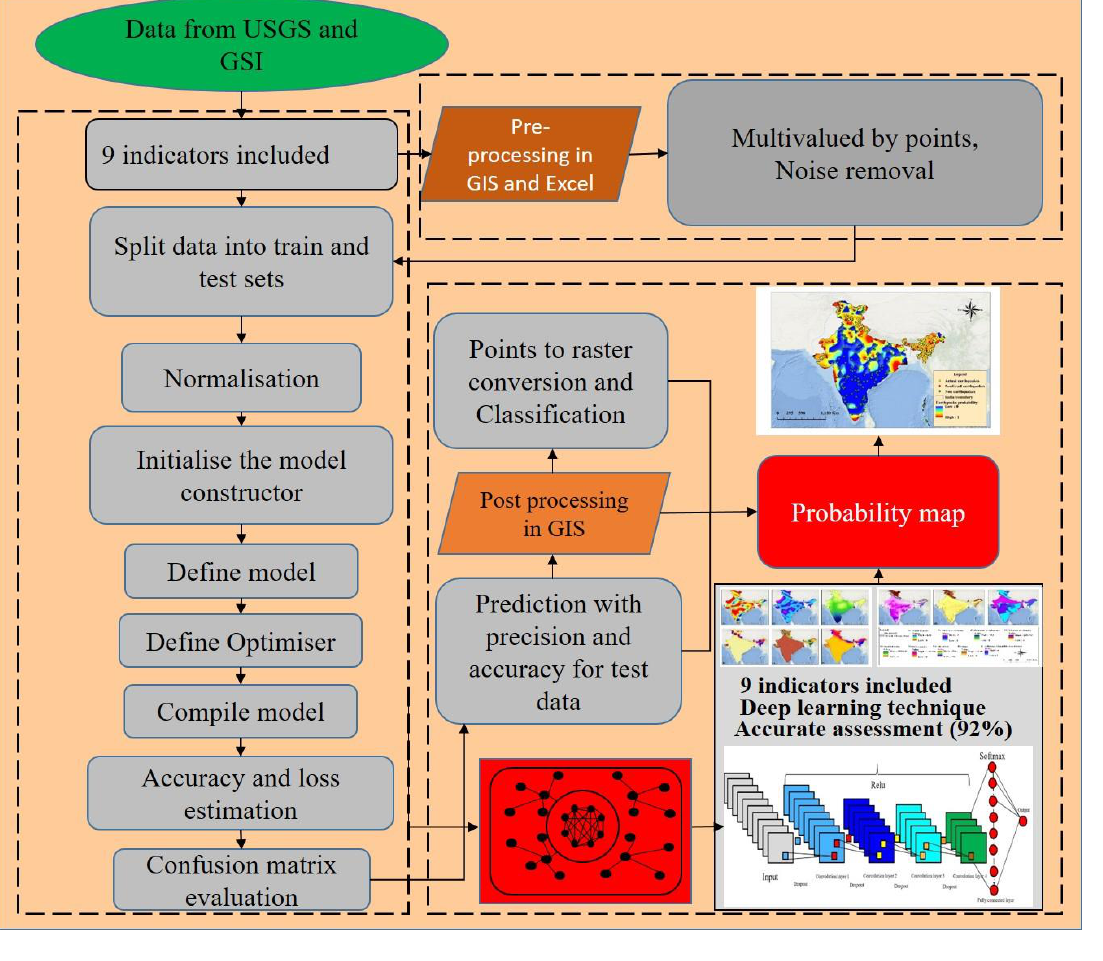
Figure 4. Methodological flowchart of the CNN model for earthquake probability assessment.